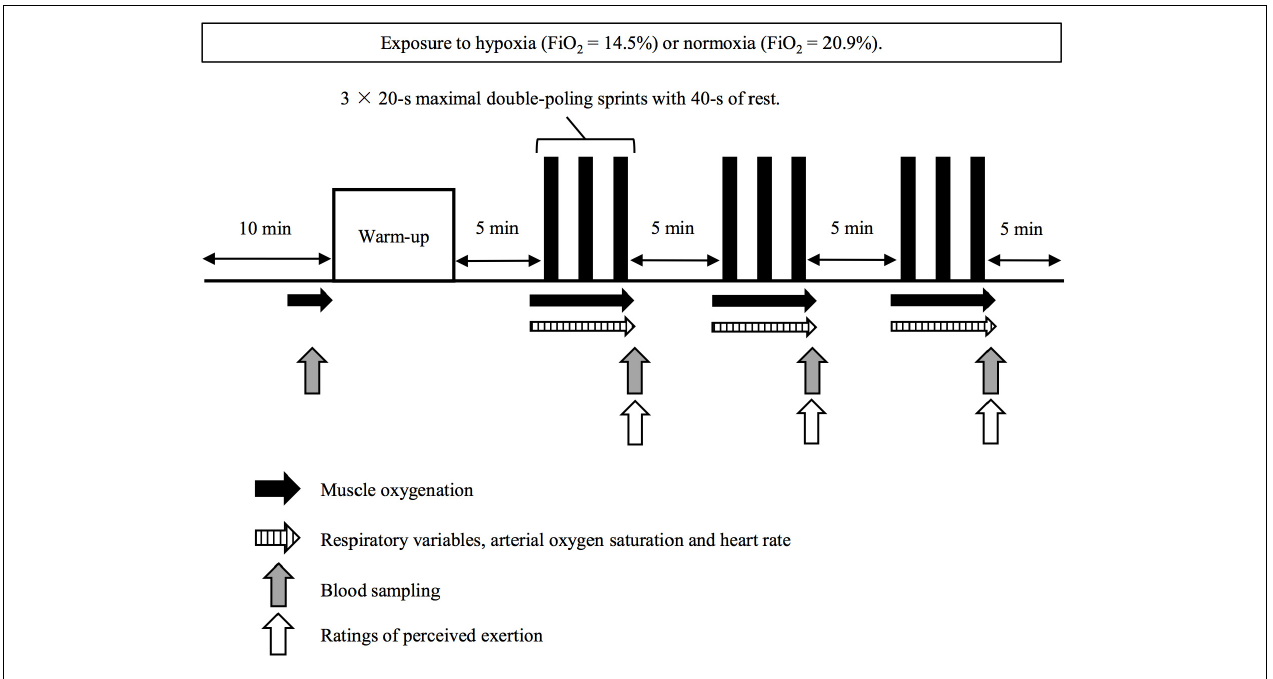
FIGURE 1 | Protocol